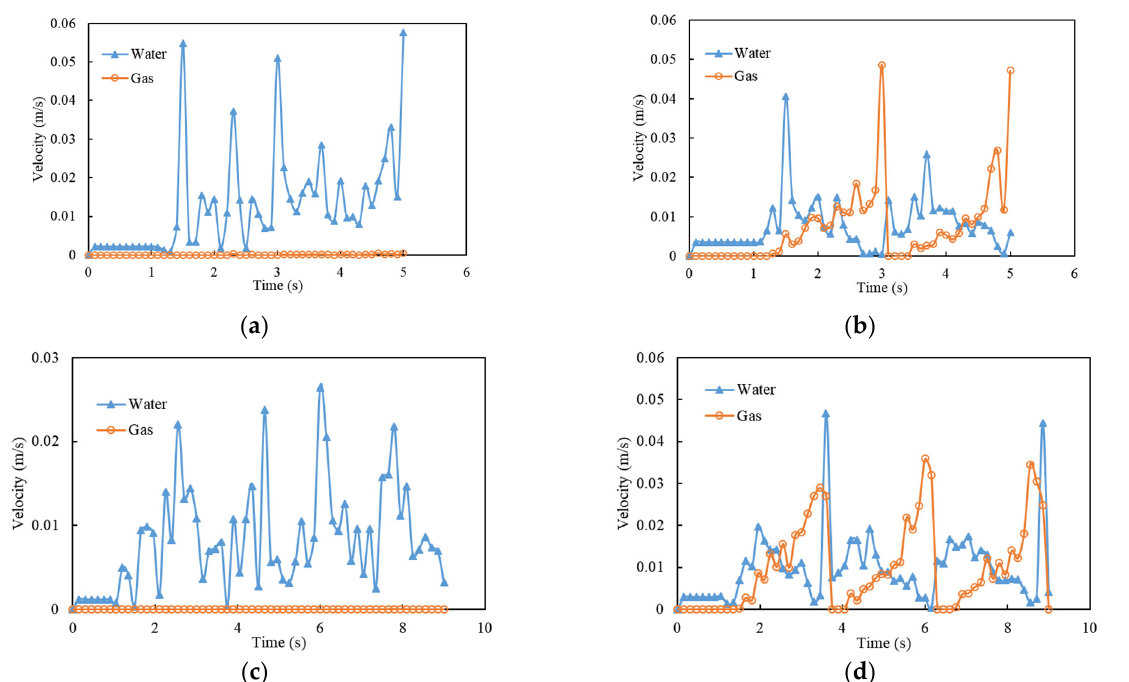
Figure 16. Flow velocity at outlets of the Y-shaped junction. ( a ) Aperture ratio = 1.5, upper outlet; ( b ) aperture ratio = 1.5, lower outlet; ( c ) aperture ratio = 2, upper outlet; ( d ) aperture ratio = 2, lower outlet.